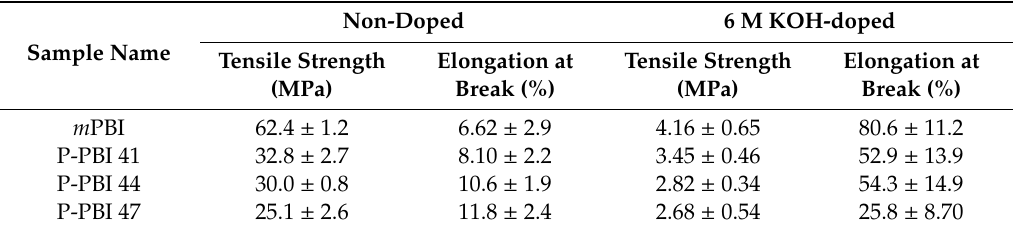
Figure 5. TGA spectra of KOH-doped P-PBI membranes. Table 3. Properties of mechanical strength of KOH-doped m PBI and P-PBI membranes.